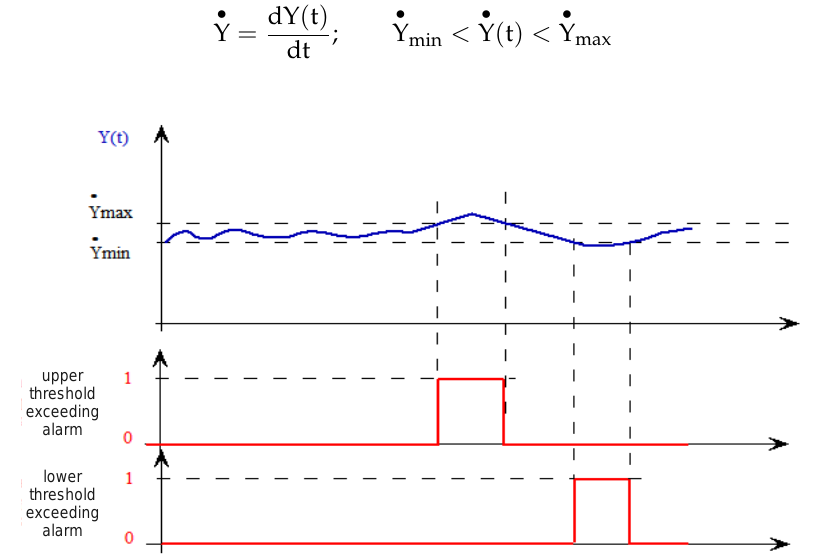
Figure 10. The fault detection method with trend checking and fixed threshold.